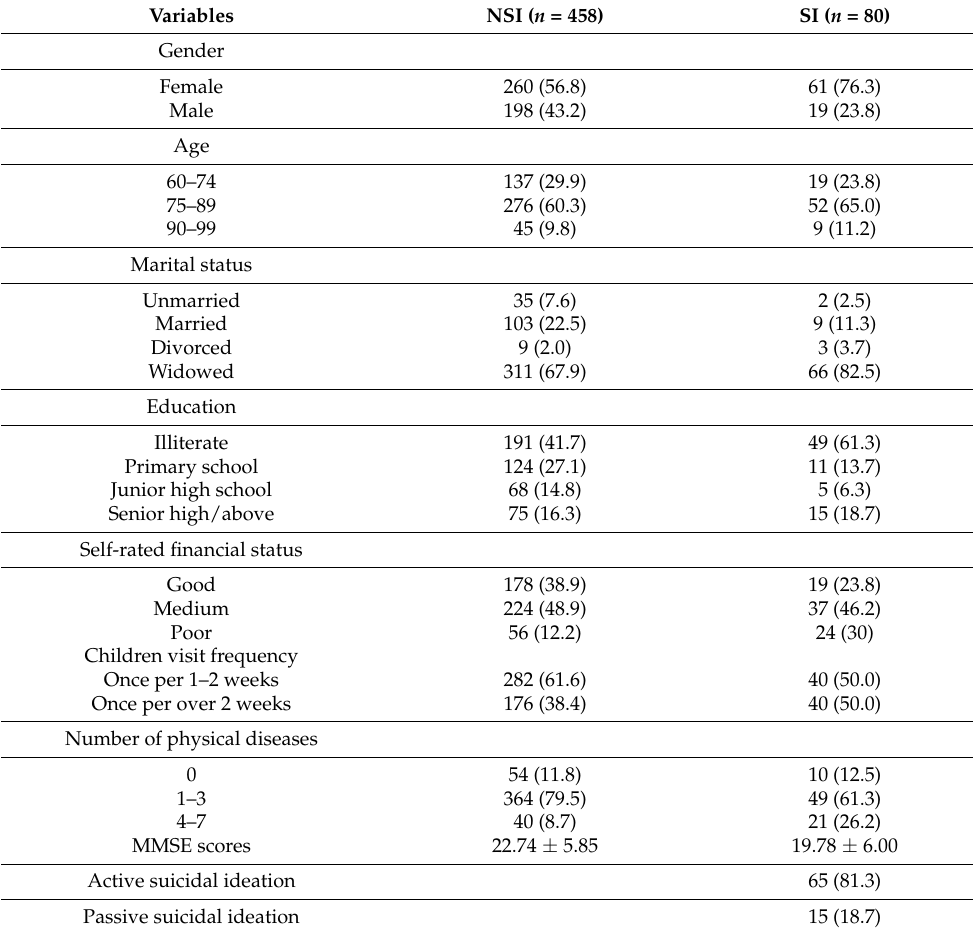
Table 1. Basic characteristics and comparison between older adults with and without suicidal ideation ( n =